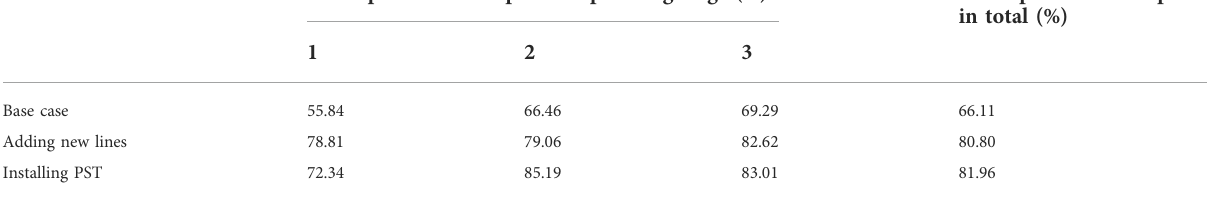
TABLE 5 IEEE 118-bus system results of installing PST and transmission network